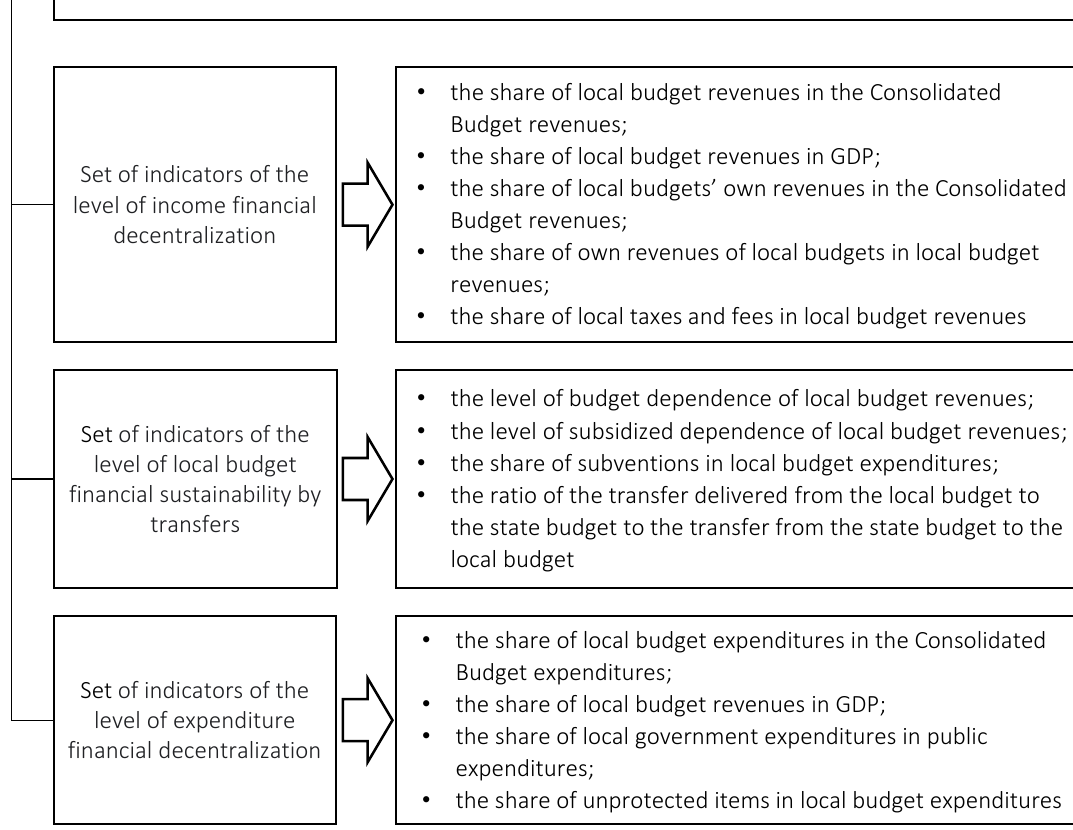
Figure 1. A scorecard of local budget financial